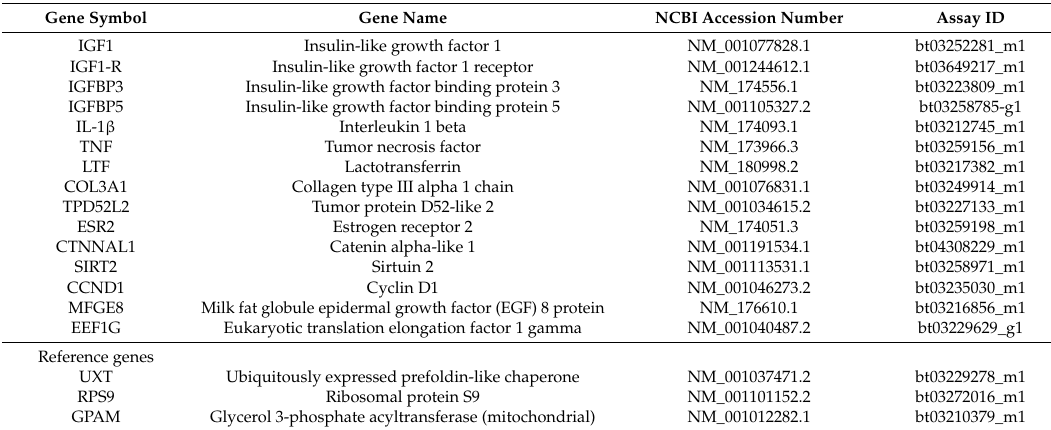
Figure 1. Gene-expression patterns in blood, milk somatic cells, and hair-follicle samples. Green cells represent expression of the target gene, and gray cells represent no expression of the target gene, in the samples of each matrix. For a list of the gene names evaluated, see Table 3. Table 3. Genes included in this study for gene-expression